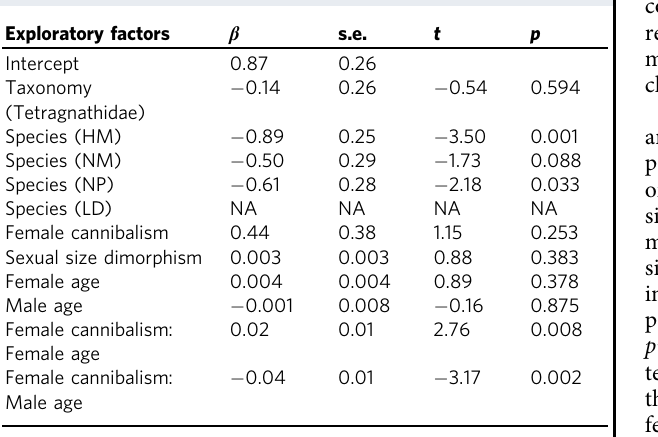
Table 2 The best fi tting GLM model including six predictors alone (taxonomy, species, presence of sexual cannibalism, sexual size dimorphism, female age, male age) and two two- way interactions to predict whether the male selects the palp with more sperm.